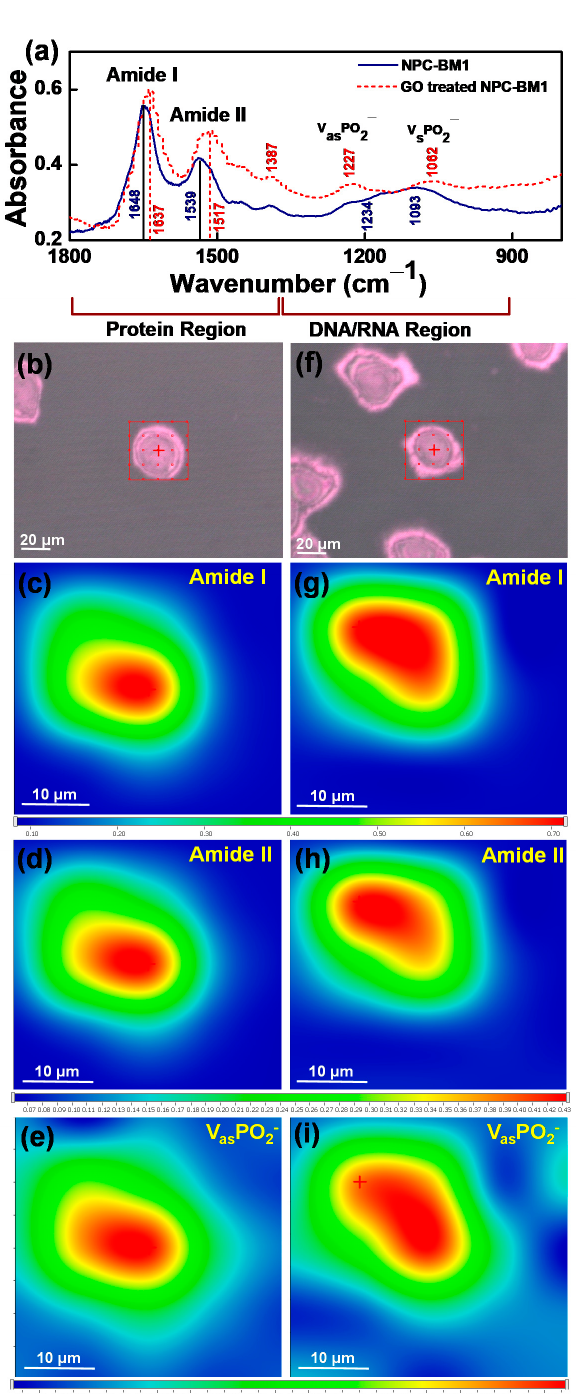
Figure 6. ( a ) FTIR spectrum of pristine and GO-treated NPC-BM1 cells, ( b , f ) microscopy images, and SR-FTIRM mapping of amide I, amide II and phosphate groups for ( c – e ) pristine NPC-BM1 cell and ( g – i ) NPC-BM1 cell treated with